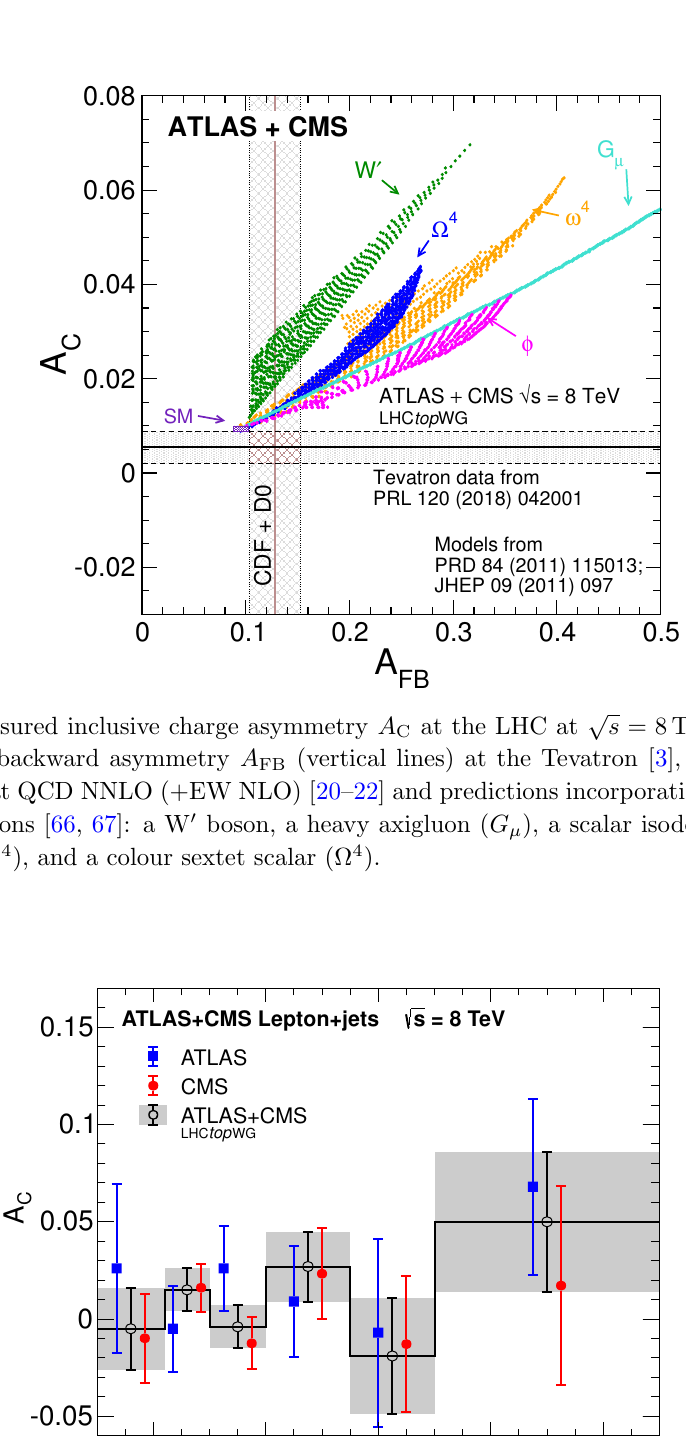
Figure 4 . Charge asymmetry in six bins of the invariant mass of the tt system as measured in the ATLAS and CMS analyses and the combined results. The last bin includes the over(cid:13)ow. The gray band indicates the uncertainty in the combined result.